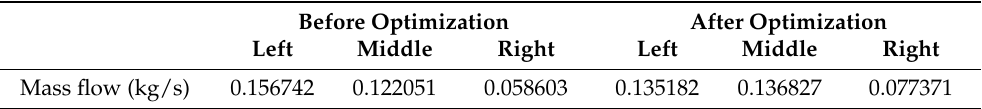
Table 6. Air mass flow of each guide channel before and after optimization.